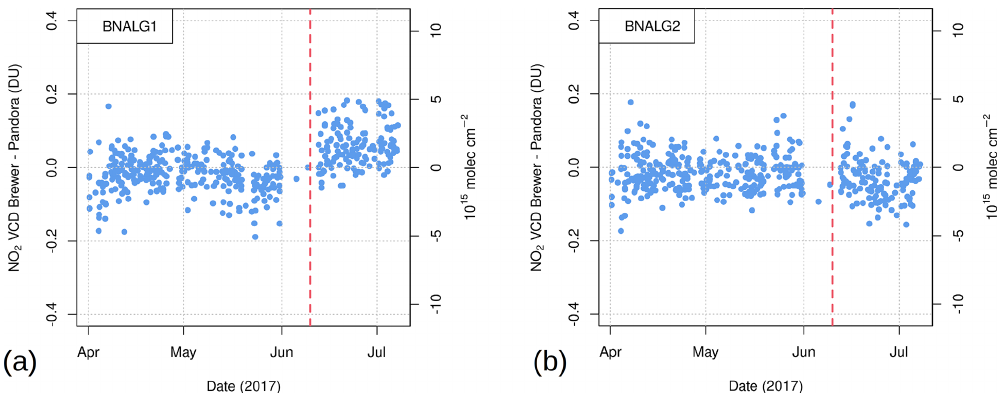
Figure 11. Difference between NO 2 retrievals from Brewer #067 – using BNALG1 (a) and BNALG2 (b) – and Pandora #117 on a portion of the data set. The vertical line shows the moment when the internal mercury lamp of Brewer #067, representing its wavelength reference, was replaced. This is sufficient to trigger a change from BNALG1, which is very sensitive to slight wavelength